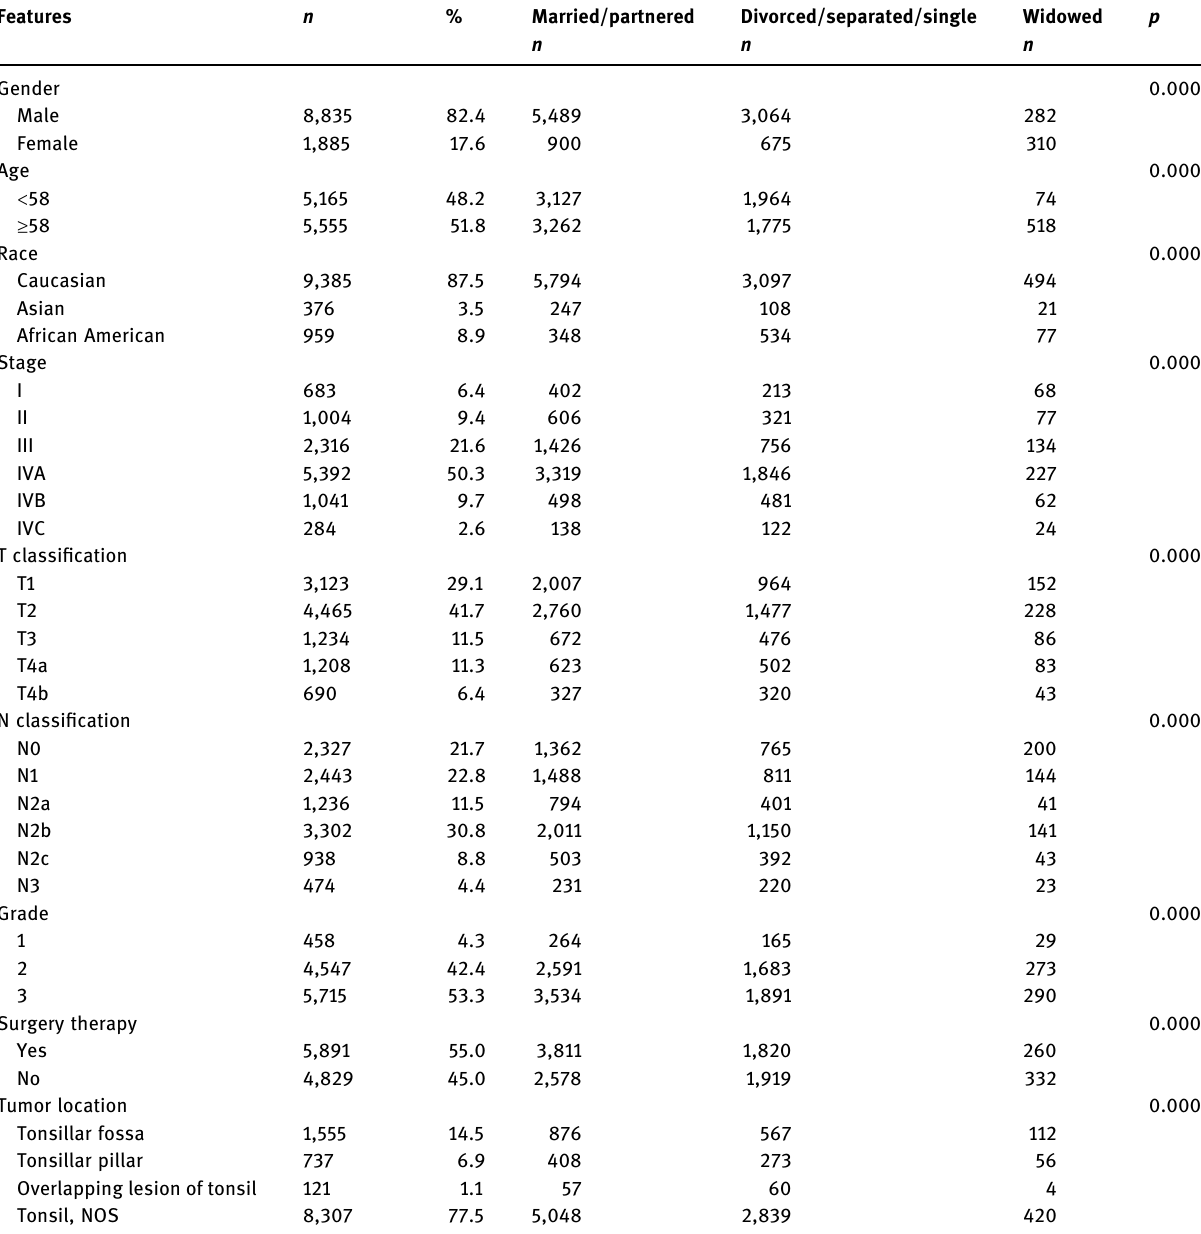
Table 1: Demographic characteristics of TSCC patients who were strati fi ed by marital status